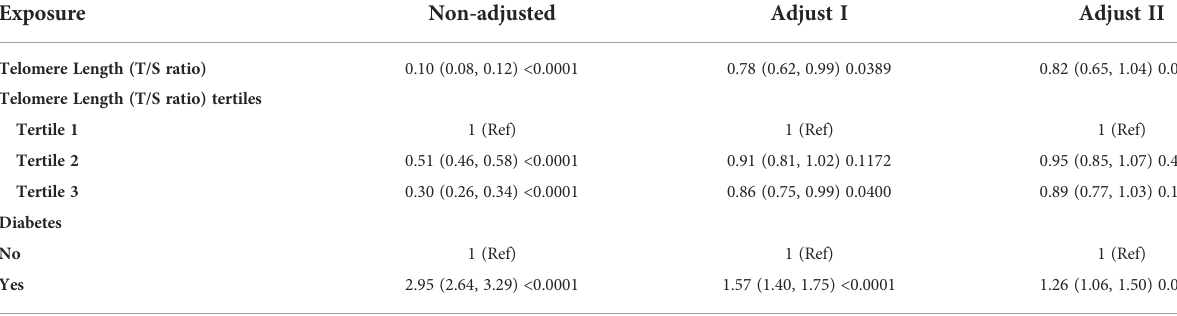
Non-adjusted model adjust for: None. Adjust I model adjust for: Age, sex, and smoking. Adjust II model adjust for: Age, sex, smoking, cancer, hypertension, CVD, MetS, eGFR, albumin, and antidiabetic